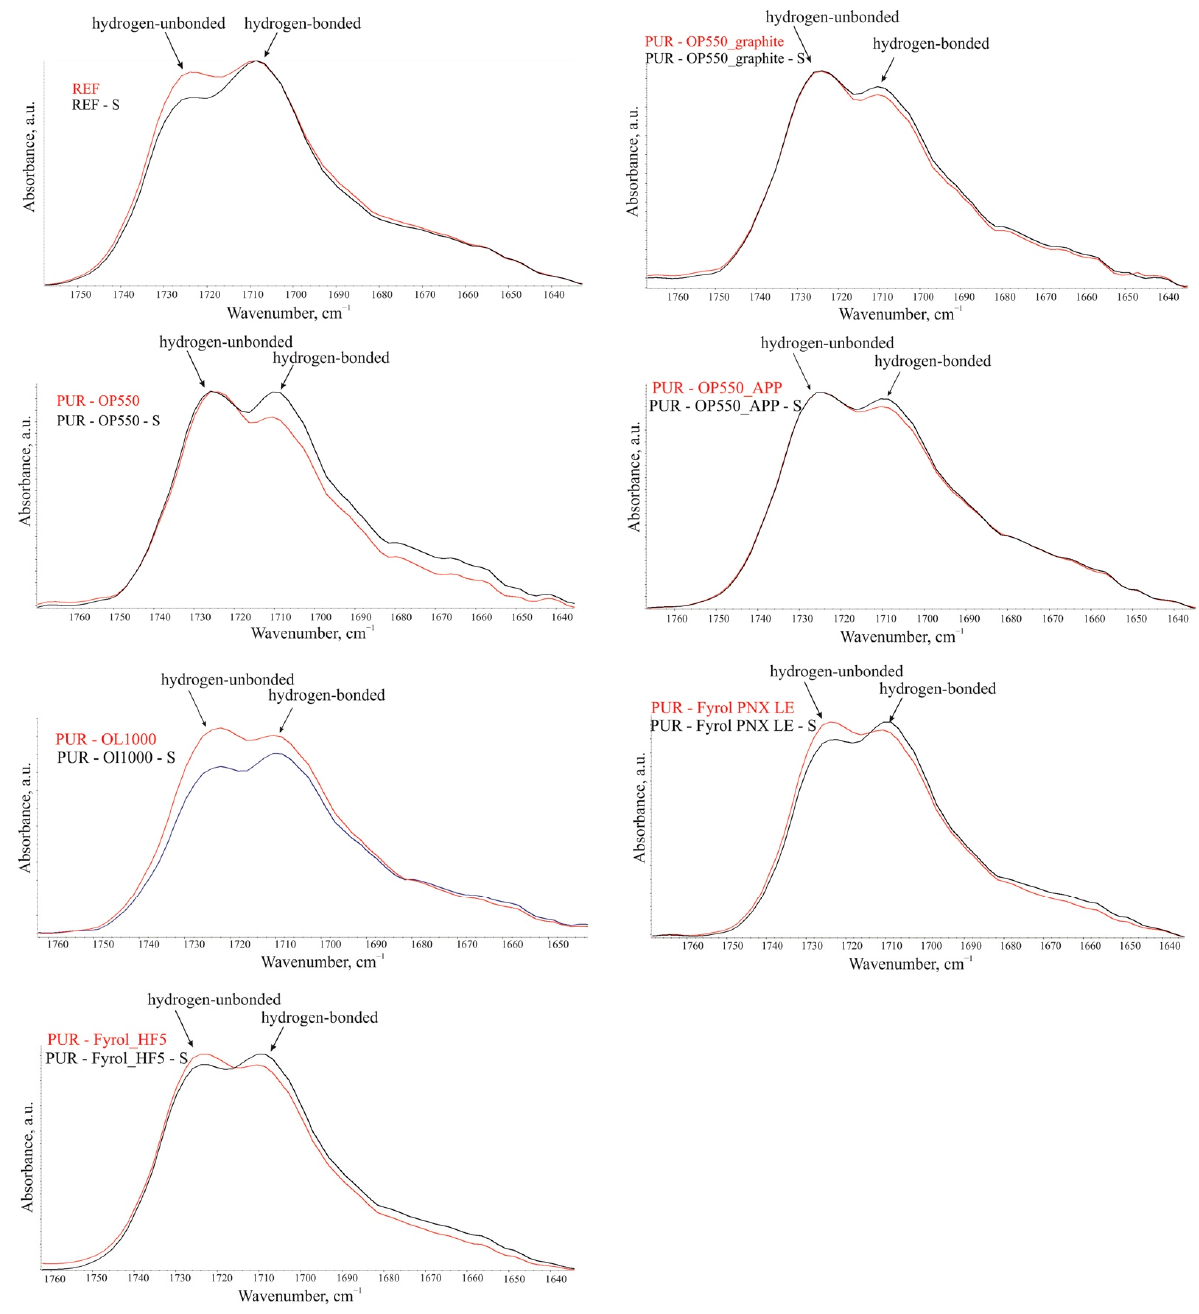
Figure 4. Summary of the 1770–1630 cm − 1 range spectra